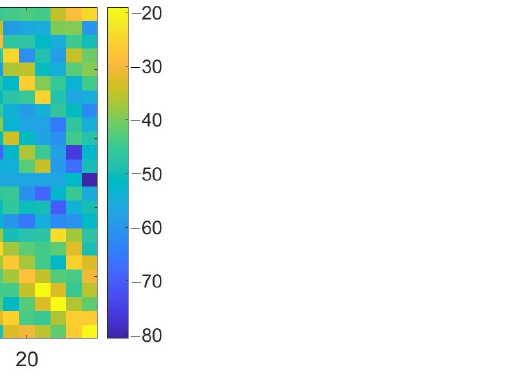
Figure 5. η p , q error, for p , q = 1, . . . , M a , dB units; ( a ) 1cm stroke radius, ( b ) 3cm stroke radius.